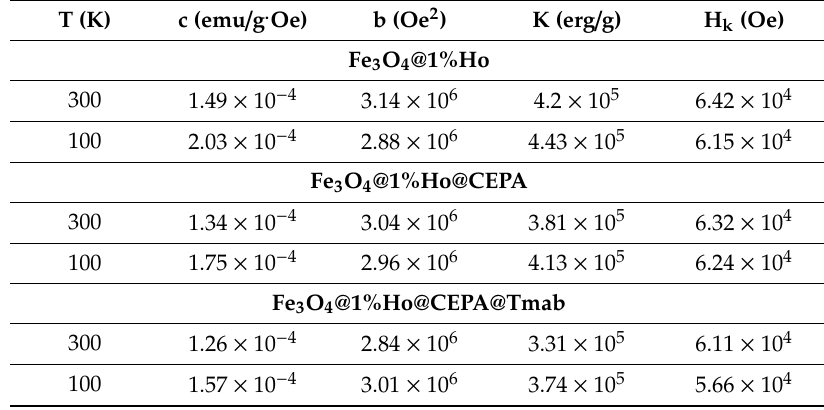
Table 3. Values of anisotropy energy K in function of temperature for samples without and with organic